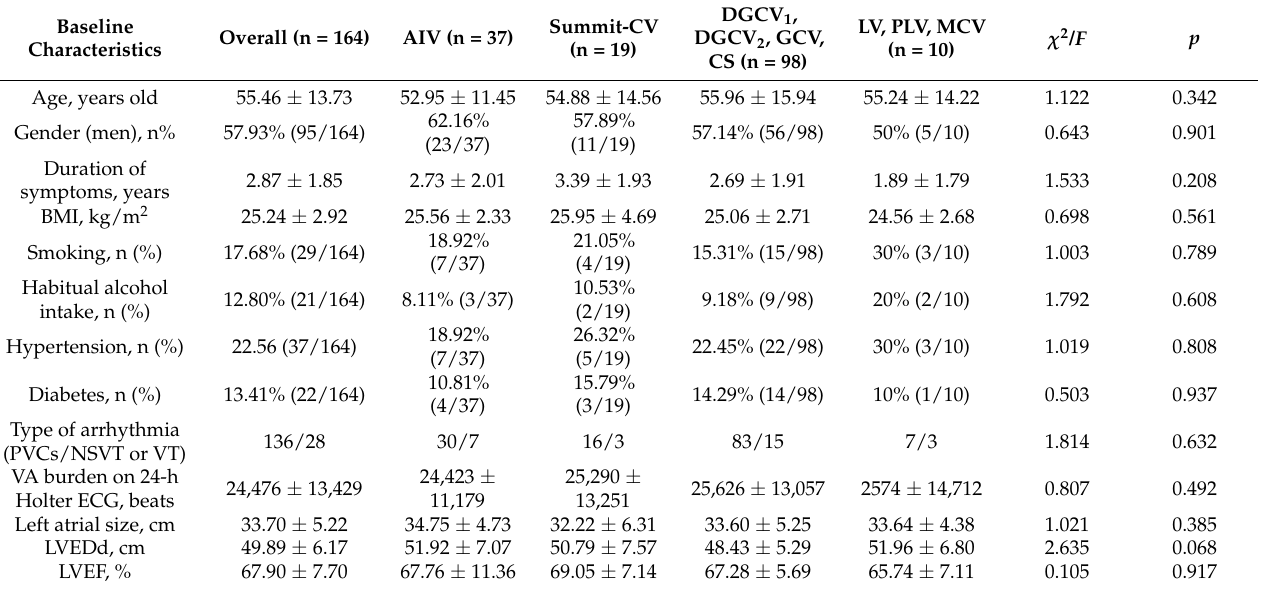
Table 1. Comparison in general clinical situation among different portions of the